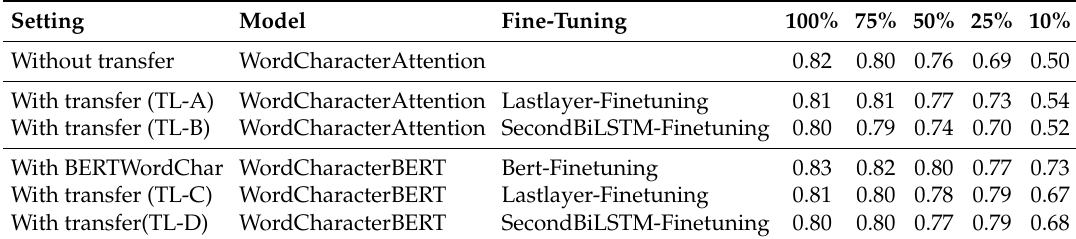
Table 10. GENE tag(BC2GM) to PROTEIN (BioNLP09) : Transfer learning results for different levels of freezing at different ratios of target training data. All scores reported are micro-F1